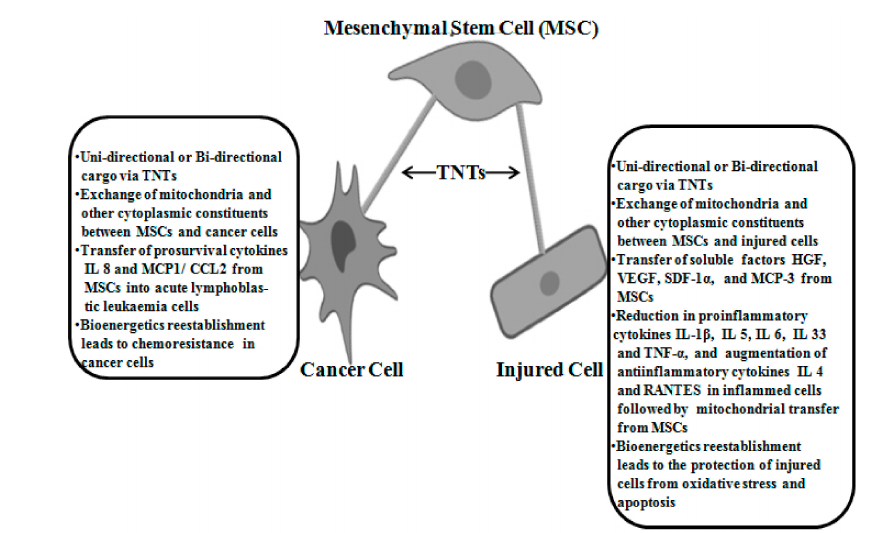
Figure 1. Tunneling nanotubes (TNTs)-mediated e ff ects of mesenchymal stem cells in injured cells and cancer